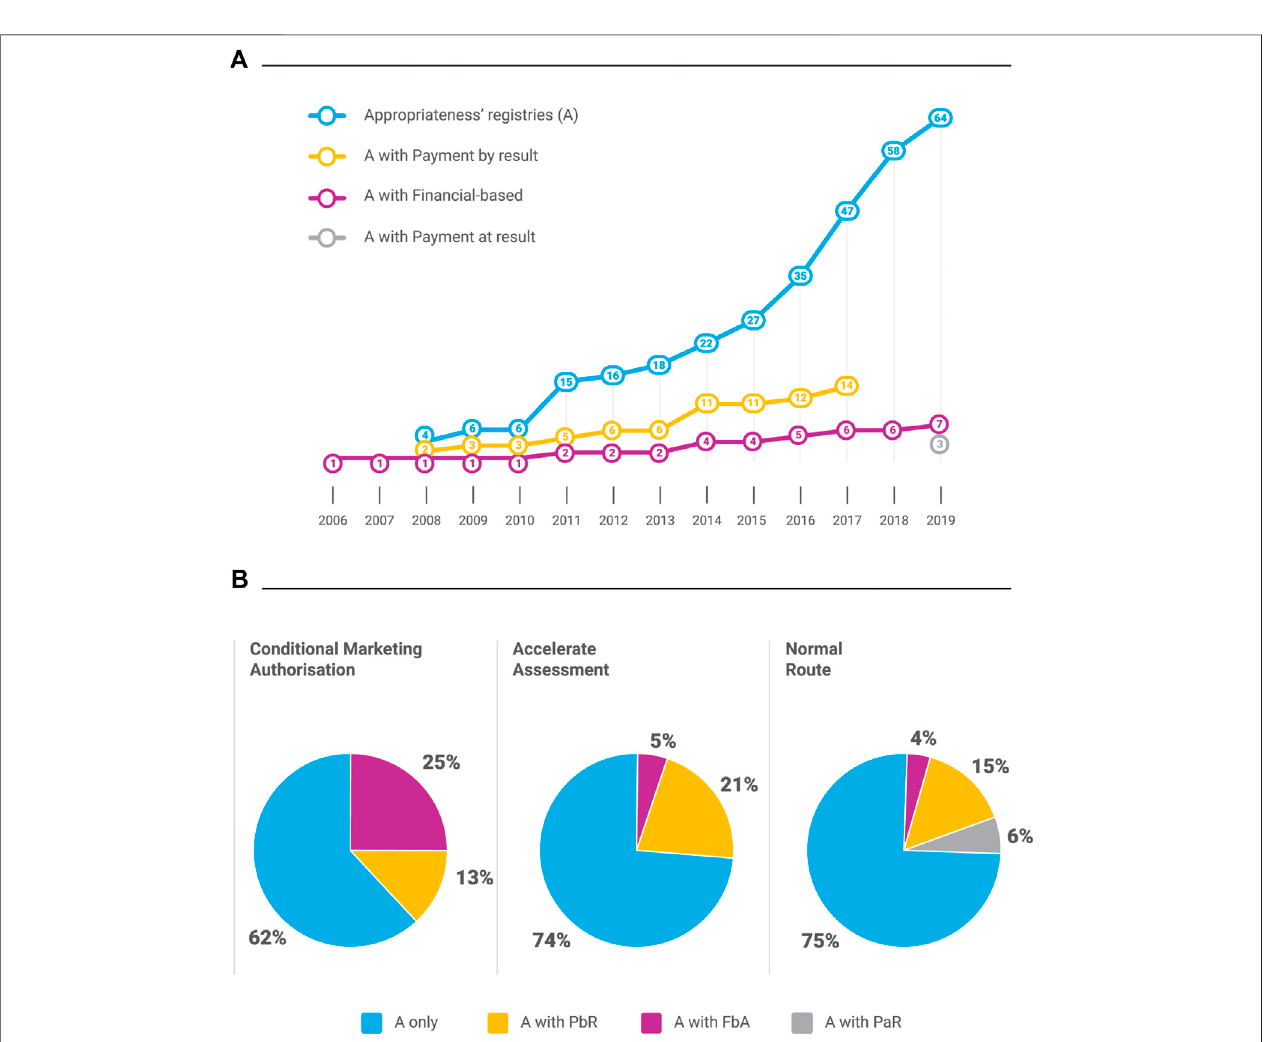
FIGURE 4 | OMP registries and EMA regulatory pathways. A, appropriateness; OMP, orphan medicinal product; PbR, payment by result; FbA, fi ncial-based agreement; PaR, payment at result.